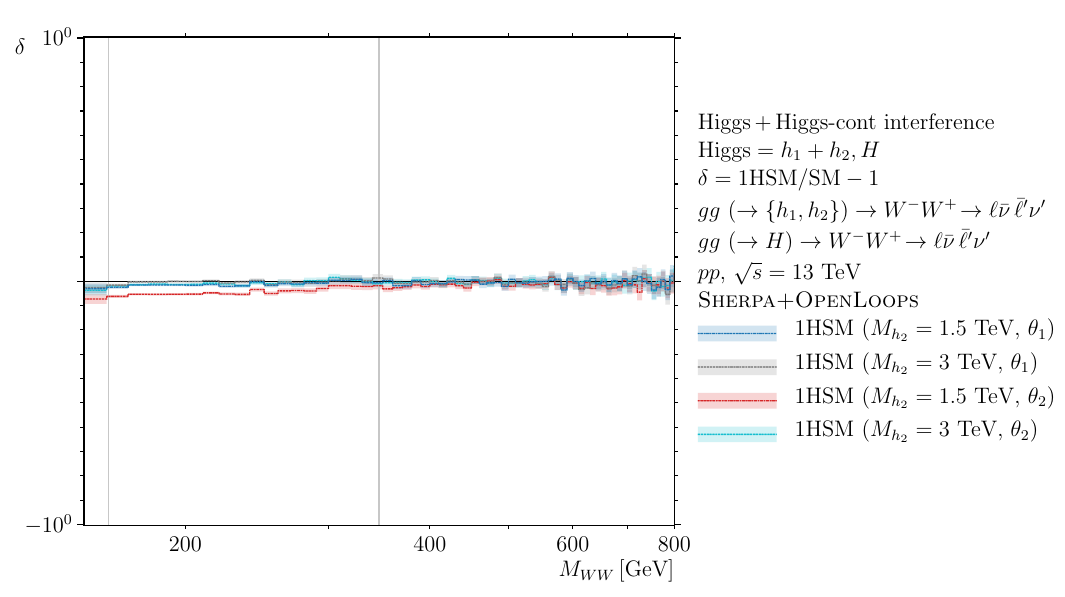
including its interference with the background in the 1HSM ( M h compared to the SM for gg ( R is the ratio of σ ( h 1+2 +I(C)) to σ ( H +I(C)). Other details as in figure 4.